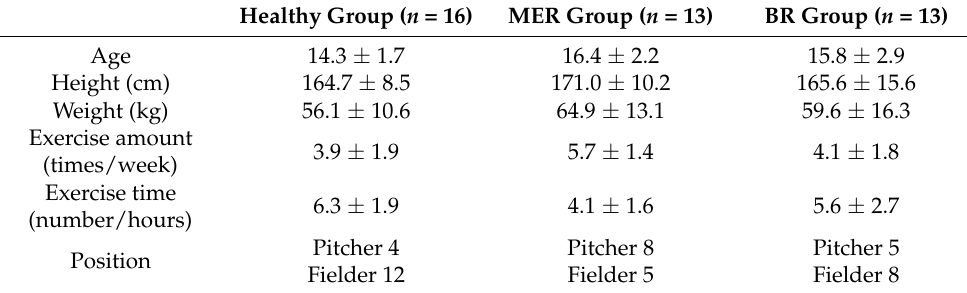
Table 2. Baseball player demographics.